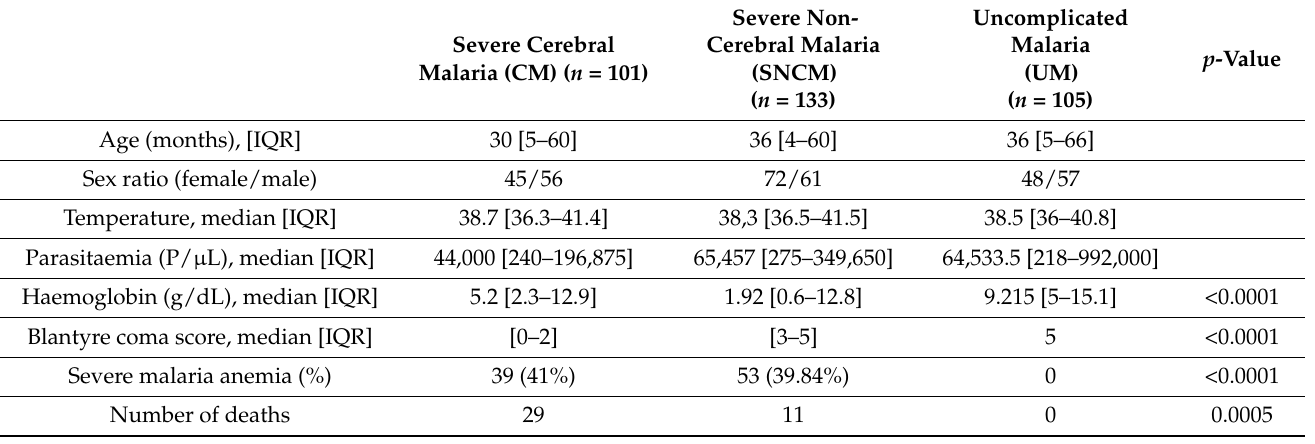
Table 1. Biological, clinical and parasitological characteristics of the Beninese children enrolled in the study at admission. Kruskal–Wallis tests in conjunction with Dunn’s multiple comparison post-hoc tests were used for comparison between the clinical groups.